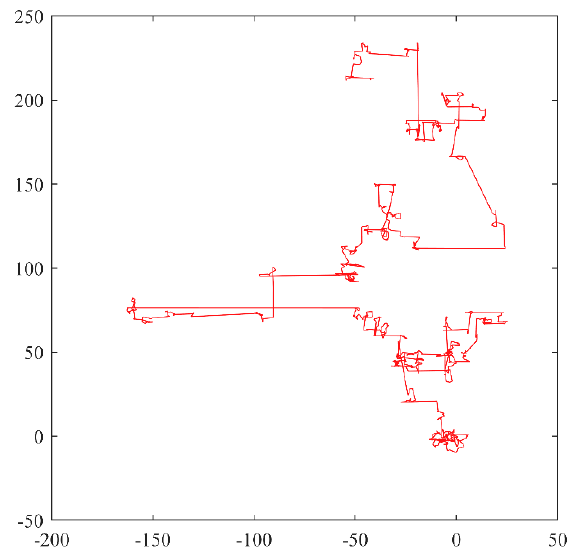
( b ) Figure 1. Chaotic tent map: ( a ) chaotic tent map bifurcation diagram; ( b ) Lyapunov exponential curve.